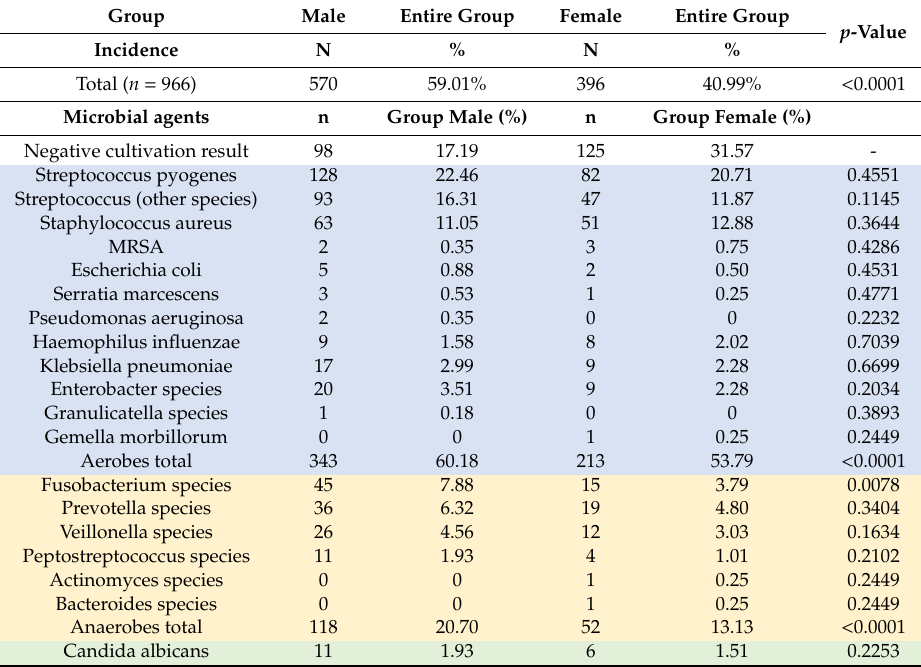
Legends: Table 2 shows PTA patient incidence (N) in both gender groups. Percentage of incidence in each gender group was calculated from the total number of patients (966). Next, the individual microbial agents cultivated (n)